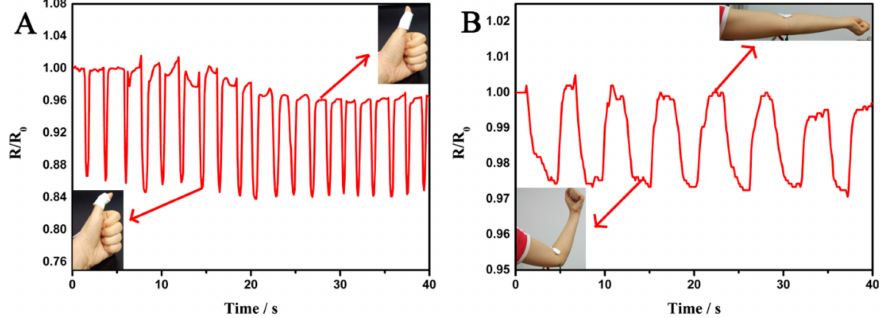
Figure 5. Responses of the nanofiber mats-based piezoresistive sensor to human thumb bending ( A ) and arm bending ( B ).